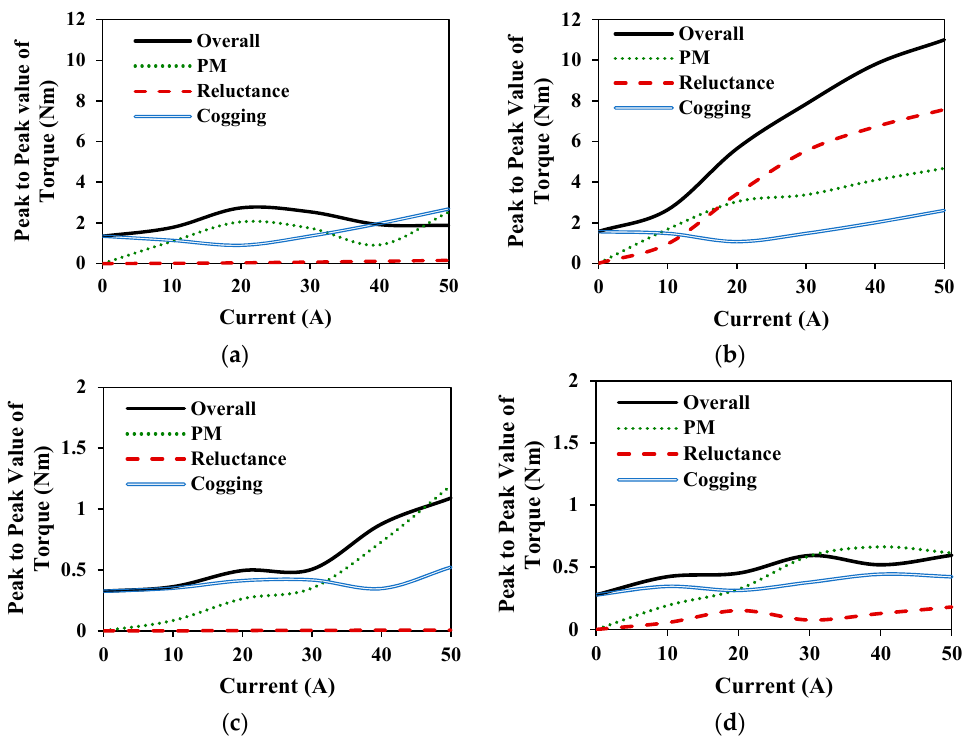
Figure 22. Peak to peak values of torque ripples for SPM and CCPPM machines. ( a ) 12s8p-SPM. ( b )